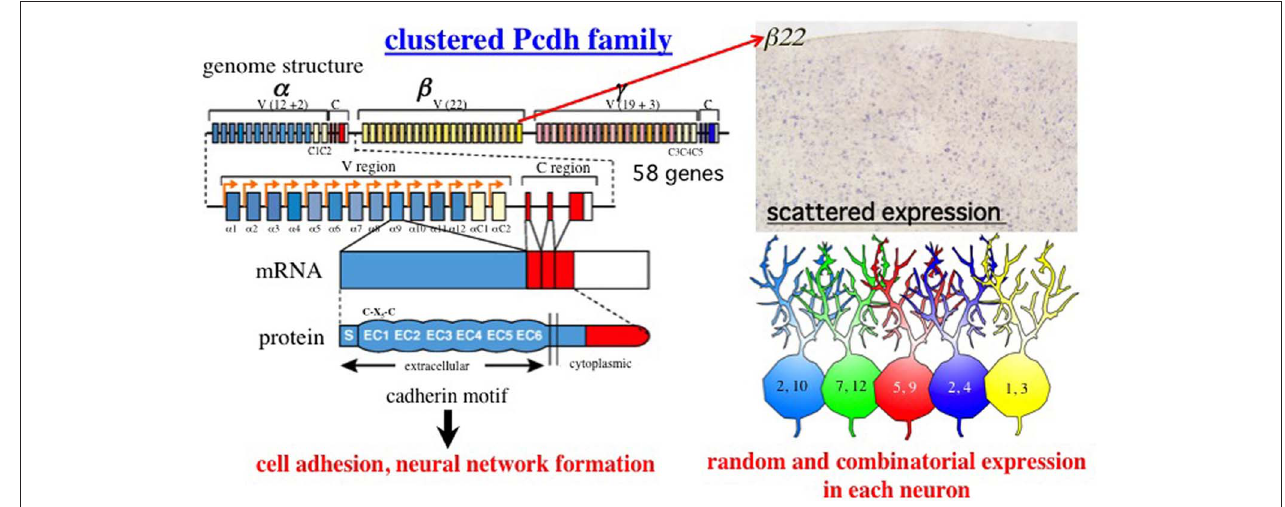
FIGURE 1 | Summary of the clustered Pcdh family. Genomic organization of the Pcdh- α , Pcdh- β , and Pcdh- γ gene clusters in mouse chromosome 18. A total of 58isoforms are encoded in these gene clusters. The mouse Pcdh- α gene consists of 14exons (12 randomly and two constitutively expressed) in the variable (V) region and a set of three constant (C) region exons (A-type alterative splicing), Not shown here, B-type is derived from four constant region exons (Kohmura et al., 1998). Similar to Pcdh- α , the Pcdh- γ cluster consists of 22 variable exons (19 randomly and three constitutively expressed) and a set of three constant region exons. Mature mRNAs of the Pcdh- α and Pcdh- γ isoforms are produced from one of these variable exons and either the α or γ constant exons. The α C1, α C2, γ C3, γ C4, and γ C5exons are closely related in homology and gene regulation. The Pcdh- β cluster does not have constant exons; instead, 22 mature isoforms are produced from large single exons. All the Pcdh- α , Pcdh- β , and Pcdh- γ isoforms consist of a signal